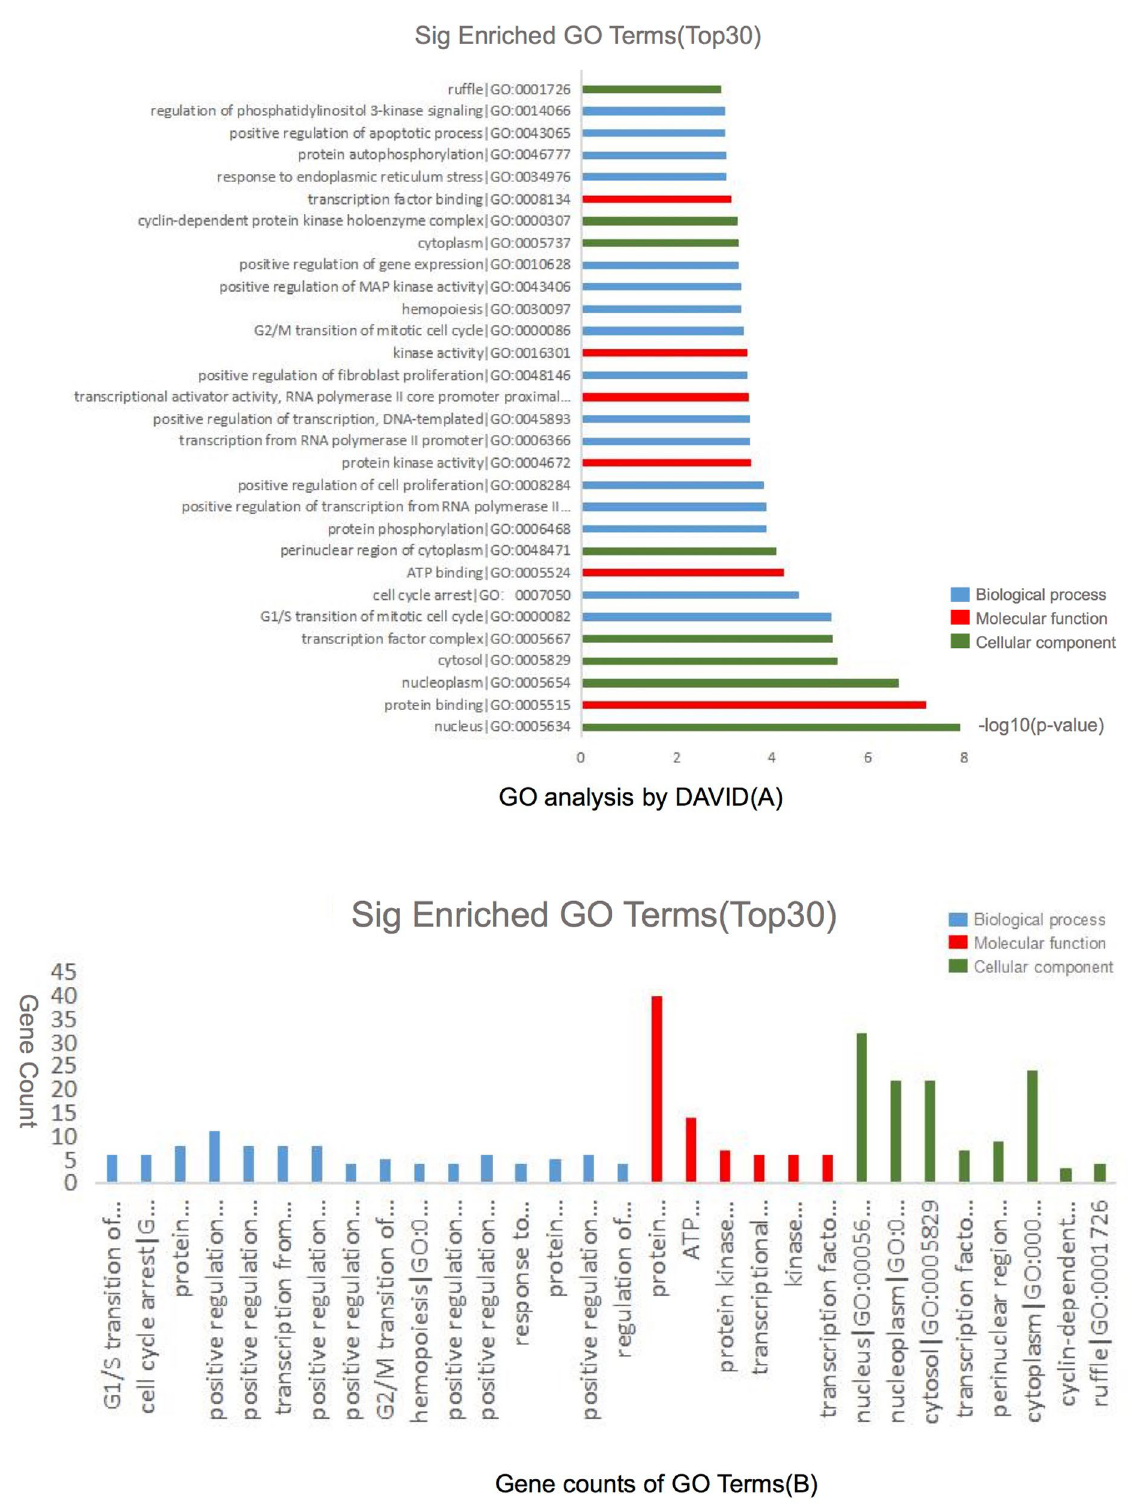
Figure 4. KEGG pathway analysis of DEmRNAs in the lncRNA–miRNA–mRNA network. ( A ) The top20 significantly enriched pathway terms by KOBAS. ( B ) The KEGG pathway interactions by Cytoscape plug-in ClueGO. Genes RUNX1, FLT3, KIT, FASLG, AKT3, MAPK8, GADD45A and PIK3R1 were enriched in pathways greater than two terms by Cytoscape plug-in